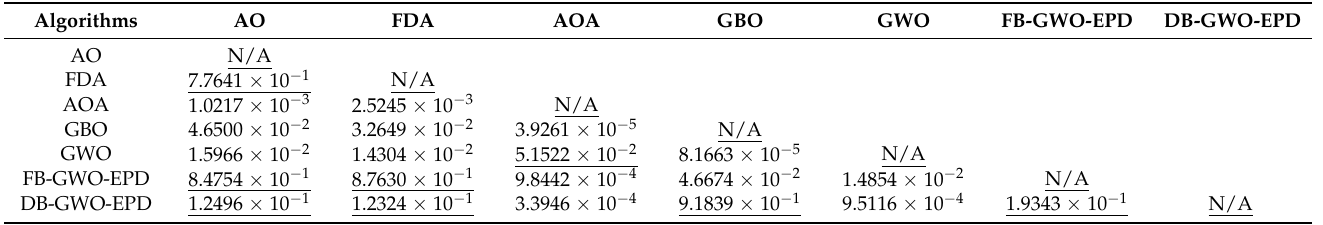
Table 7. p -values calculated for the shifted classical functions ( p -values ≥ 0.05 have been underlined).